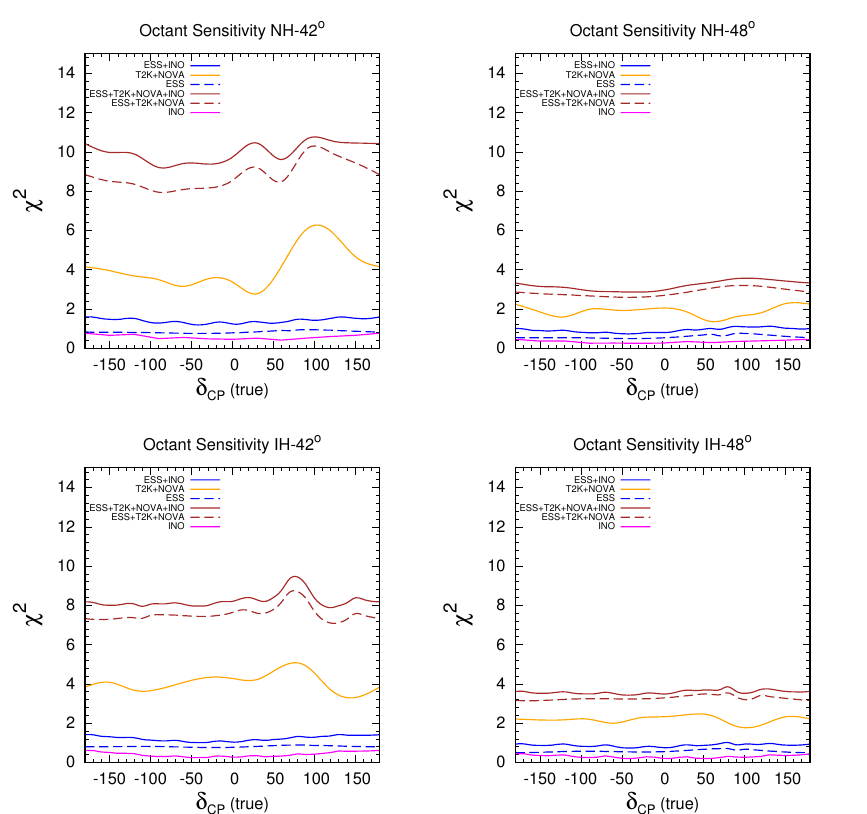
Figure 6 . Octant sensitivity vs. (cid:14) CP (true) for ICAL@INO-3D ESS (cid:23) SB T2K NO (cid:23) A for four hierarchy-octant combinations starting from top right, clockwise in the order NH-LO, NH-HO, IH- HO and IH-LO. Each (cid:12)gure consists of six di(cid:11)erent experimental combinations which are represented as ICAL@INO (magenta solid curve), ESS (cid:23) SB (blue dashed curve), T2K + NO (cid:23) A (orange solid curve), ESS (cid:23) SB + ICAL@INO (blue solid curve), ESS (cid:23) SB + T2K + NO (cid:23) A (brown dashed curve) and ESS (cid:23) SB + T2K + NO (cid:23) A + ICAL@INO (brown solid